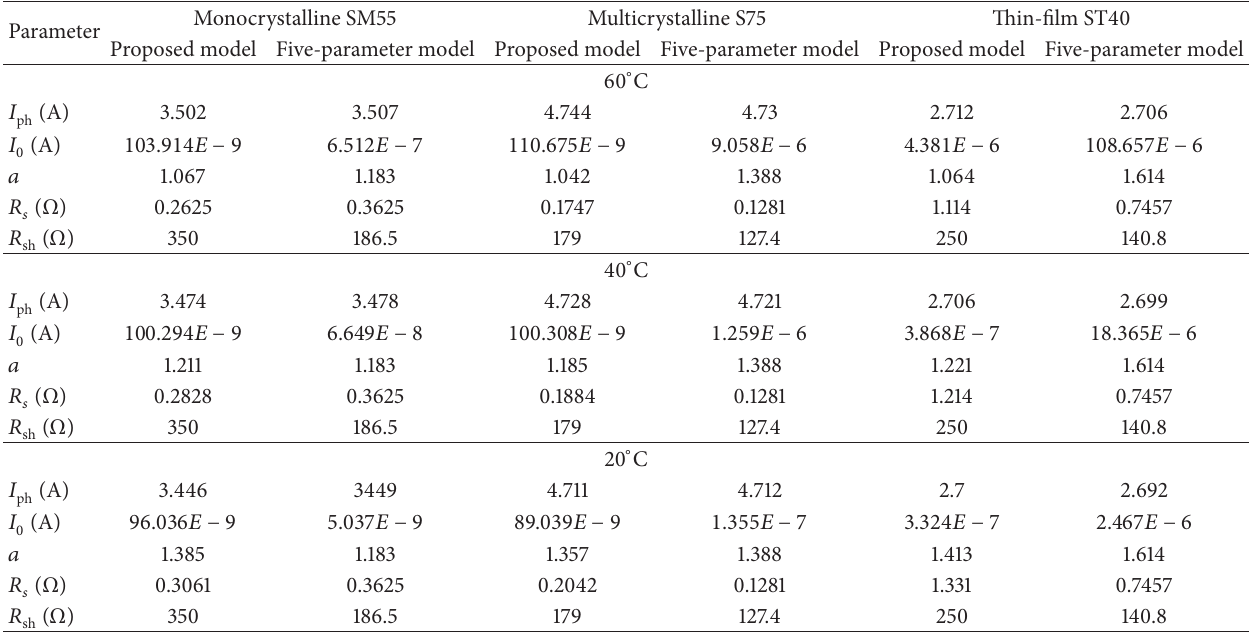
Table 4: Parameters for the proposed model ( 𝐺 = 1000 W/m 2